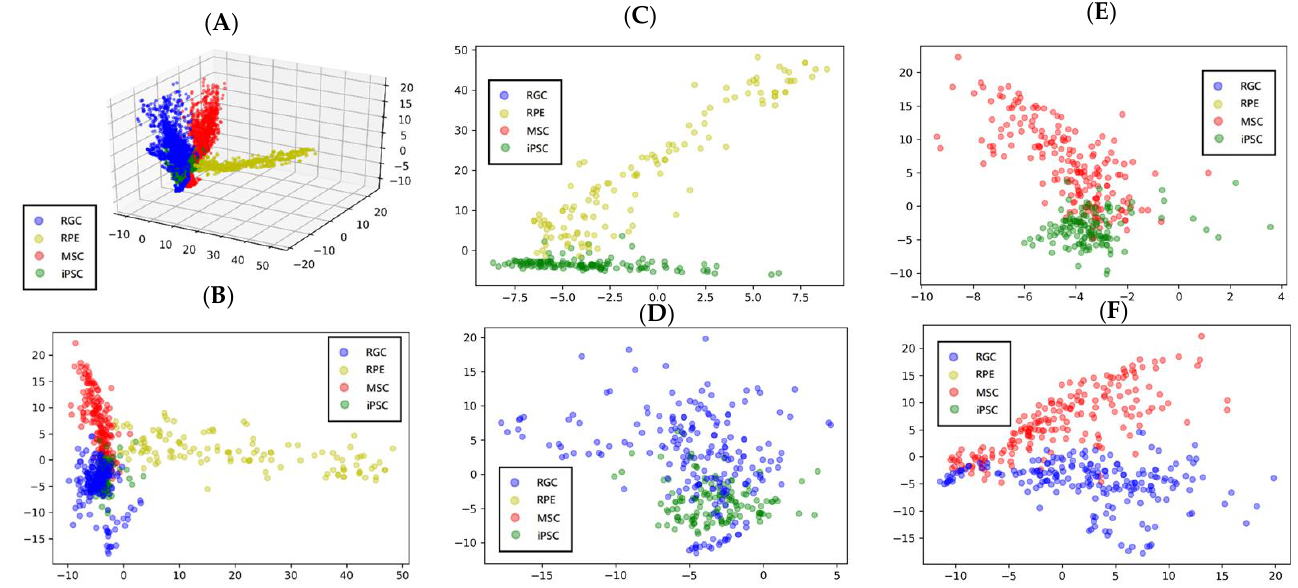
Figure 7. Three-dimensional projection, the maximum projection results, and two-dimensional projection of iPSCs, iPSC-MSCs, iPSC-RPEs, and iPSC-RGCs after using PCA for the output of the multi-slice tensor model. ( A ) The three-dimensional projection of four cell types; ( B ) Results of the maximal 2D projection; ( C ) The projection of iPSCs and iPSC-RPEs ( D ) the projection of iPSCs and iPSC-RGCs; ( E ) the projection of iPSCs and iPSC-MSCs; ( F ) the projection of MSCs and iPSC-RGCs.